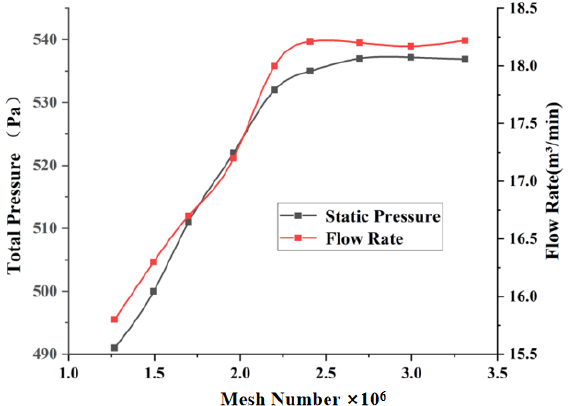
Figure 4. Grid independence verification.